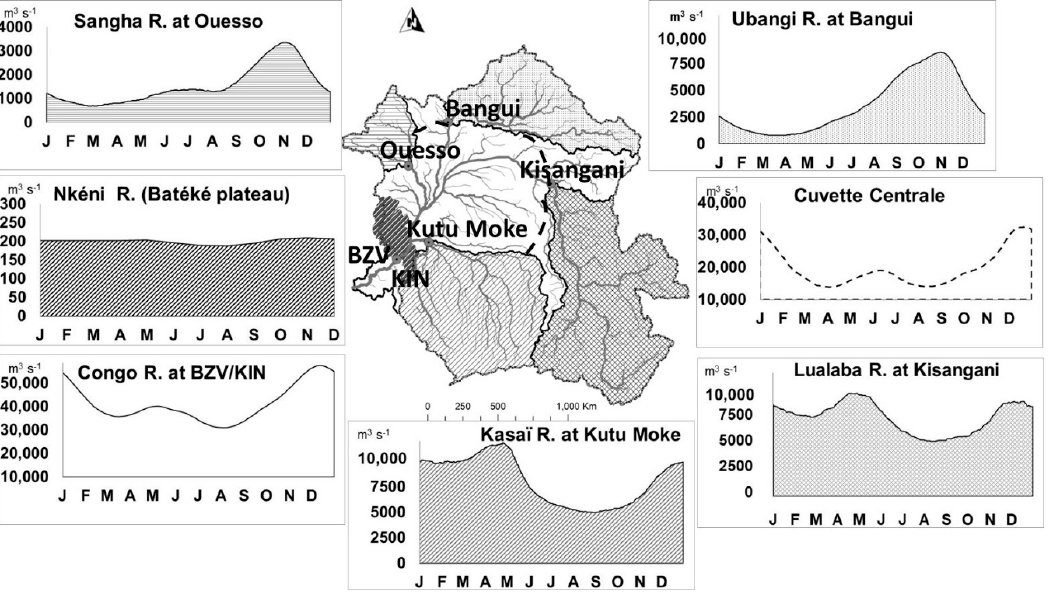
Figure 10. Graph Comparison of the hydrological regimes of the six main drainage units of the Congo Basin and of the whole Congo basin [13]. Legend: the dashed line encircles the ‘Cuvette Centrale’. The evolution of hydrological regimes by periods of homogeneous flow for the studied drainage entities, according to their available flow records are presented in Moukandi N’kaya et al. (accepted and in press) [13]. The two longest records (Congo at BZV/KIN and Ubangi at Bangui) are now detailed.